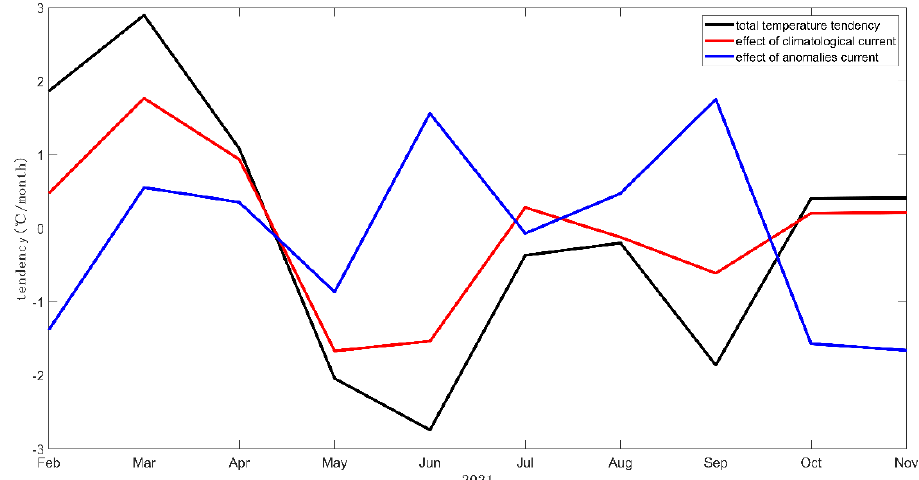
Figure 8. Temperature tendency at the thermocline depth in the incursion region (2° S − 0°, 122° W − 110° W) in 2021. The black line shows the total temperature tendency. The red and blue lines represent the effect of the climatological current with temperature anomalies and anomalous current with temperature anomalies on the temperature tendency, respectively.